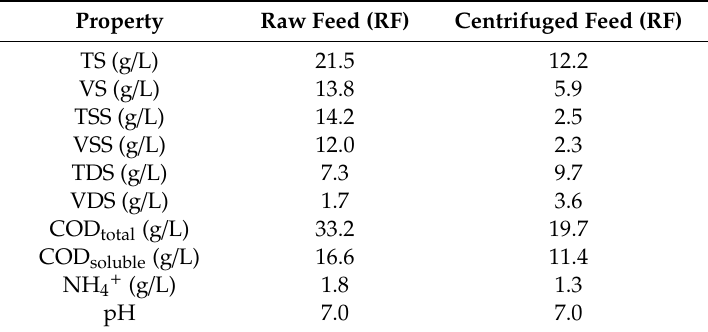
Table 1. Feed sample